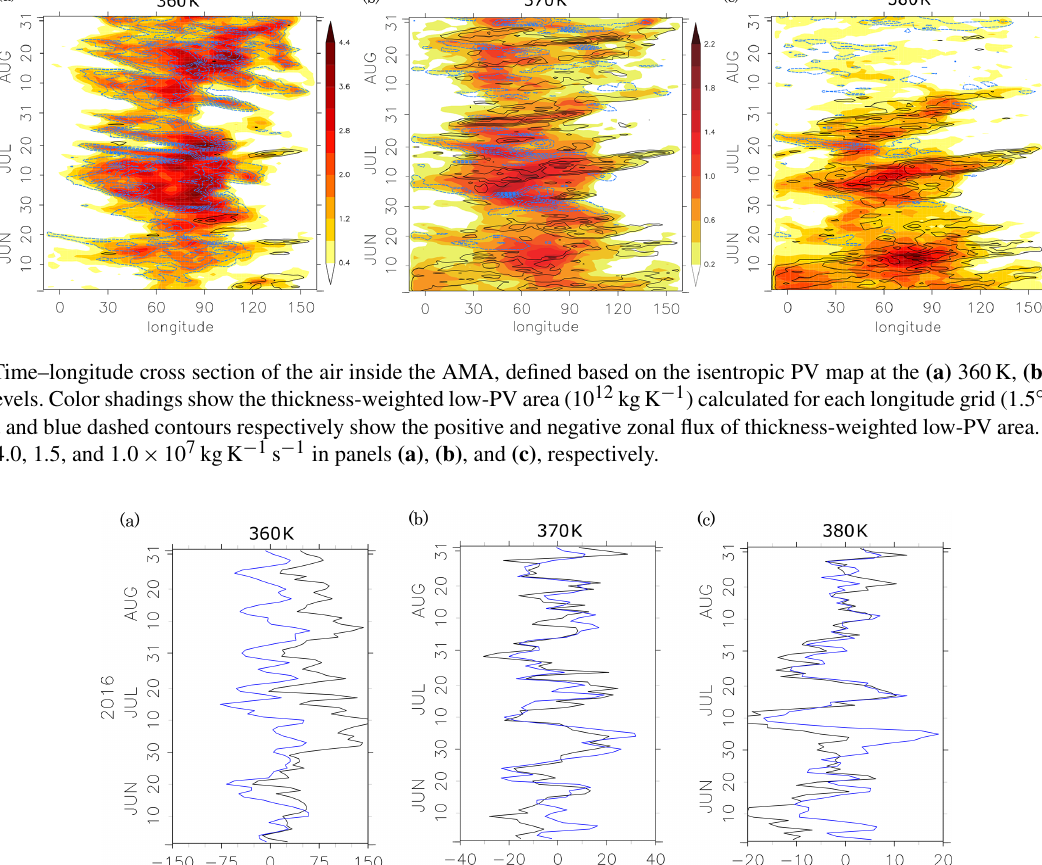
Figure 5. The tendency of the partial thickness-weighted anticyclone area d flux entering the area − ˆ F at 60 ◦ E (black: the first term on the right-hand side) calculated at the (a) 360K, (b) 370K, and (c) 380K levels. The unit of the horizontal scale is 10 6 kgK − 1 s − 1 .